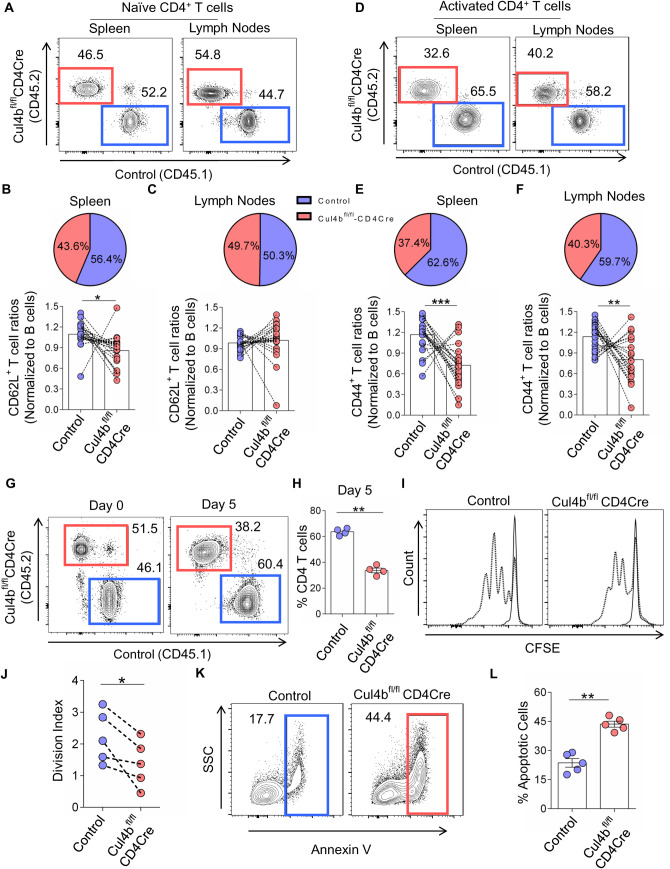
Cul4b regulates homeostasis, proliferation, and survival of activated CD4+ T cells.T cell-depleted BM cells were injected into sublethally irradiated Rag1−/− recipient mice. Congenically marked BM cells from Cul4bfl/fl-CD4Cre (CD45.2) and control (CD45.1) were mixed into 1:1 ratio, and 2 × 106 cells were injected into each recipient mouse. (A) The comparison of the naïve (CD62LhiCD44lo) CD4+ populations in the spleen and lymph nodes of irradiated recipient chimeric mice after reconstitution of BM cells from control mice (CD45.1+) and Cul4bfl/fl-CD4Cre mice (CD45.2+). (B and C) The line graphs show the relative ratios of CD62LhiCD44lo CD4+ T cells. Ratios were calculated by dividing the percentages of naïve T cells of each genotype with the percentages of B cells from the same genotype. The pie chart depicts the relative percentages of the control and Cul4bfl/fl-CD4Cre CD62LhiCD44lo CD4+ T cells (D–F). The comparison of activated/effector memory (CD62LloCD44high) CD4+ T cells in the spleens and lymph nodes of the recipient chimeric mice. The line graphs show the relative ratio of CD62loCD44high T cells calculated by dividing the percentages of activated T cells with the percentages of B cells from the respective genotypes. The pie chart depicts the relative percentages of the control and Cul4bfl/fl-CD4Cre CD62LloCD44hi CD4+ T cells. Data from 20 recipient mice are shown; experiment was repeated twice with 2 donors in each experiment (n = 5, recipients for each donor (n = 4)) (*P < 0.05 **P < 0.01, ***P < 0.001 by Student t test). (G) Naïve CD4+ T cells isolated from control mice (CD45.1+) and Cul4bfl/fl-CD4Cre mice (CD45.2 mice were cocultured and stimulated in vitro with anti-CD3 and CD28 mAbs (5 μg/ml) for 5 days. The relative proportions of the cells were assessed by flow cytometry. (H) The bar graph shows the mean ± SEM percentages of cells of 4 independent experiments (n = 4). **P < 0.01 by Student t test. (I) Naïve CD4+ T cells isolated from control (CD45.1+) and Cul4bfl/fl-CD4Cre (CD45.2+) mice were labeled with CFSE, then cocultured and stimulated in vitro with anti-CD3 and CD28 mAbs (5 μg/ml) for 3 days. Representative flow cytometry histograms of CFSE-labeled CD4+ T cells are shown. (J) Division index was calculated with FlowJo software. Division index of 5 independent experiments is compiled. (*P < 0.05 by Student t test). (K) Naive CD4+ T cells were stimulated with anti-CD3 and CD28 mAbs (5 μg/ml) for 3 days to allow multiple rounds of cell divisions. After day 3, cells were stained with Annexin V-FITC antibody. The percentage of apoptotic cells (Annexin-V+) were analyzed by flow cytometry. (L) Bar graph shows quantitation of the percentage of apoptotic (Annexin V positive) cells of 5 independent experiments (n = 5). (**P < 0.01, by Student t test). For numerical raw data, please see S5 Data. BM, bone marrow; CFSE, carboxyfluorescein succinimidyl ester; Cul4b, Cullin-4b; mAbs, monoclonal antibodies; SEM, standard error of mean.